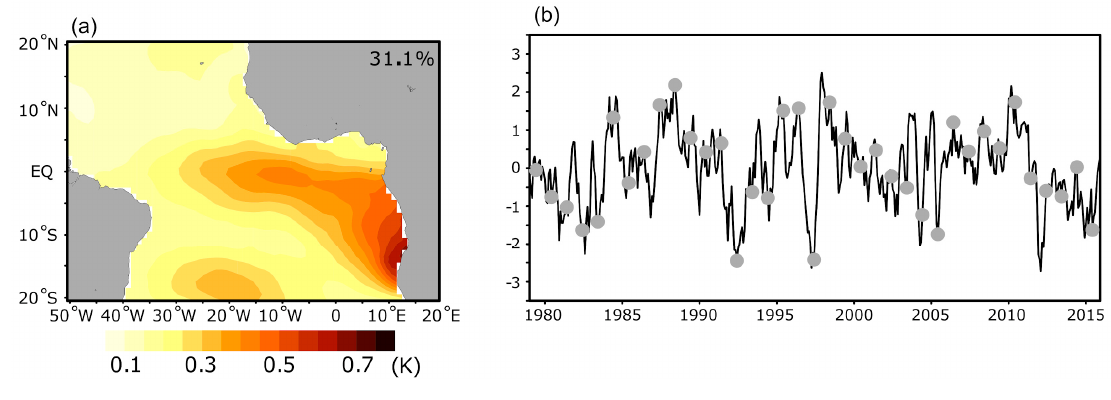
Figure 4. ( a ) Empirical Orthogonal Function (EOF) 1st mode for 12-monthly anomaly of SST (1979–2015) obtained from TropFlux and ( b ) its principal component (PC) score normalized by the standard deviation of the PC score. The gray dots denote the PC score in June for each year.